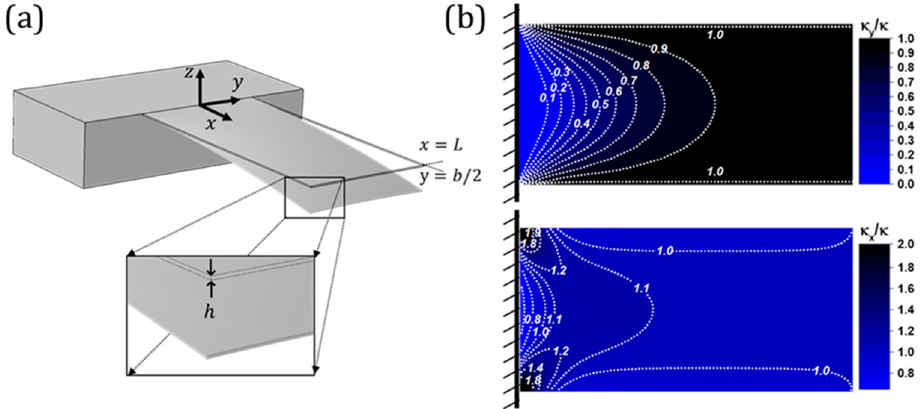
Figure 2. ( a ) Schematic of a cantilever plate that has been bent by the action of differential surface stress between the upper and lower faces. ( b ) Contour lines of the longitudinal and transversal curvatures normalized to Stoney’s curvature for a cantilever plate. It can be seen that, far from the clamped region, both curvatures follow Stoney’s equation, which is not the case for the region close to the clamping.